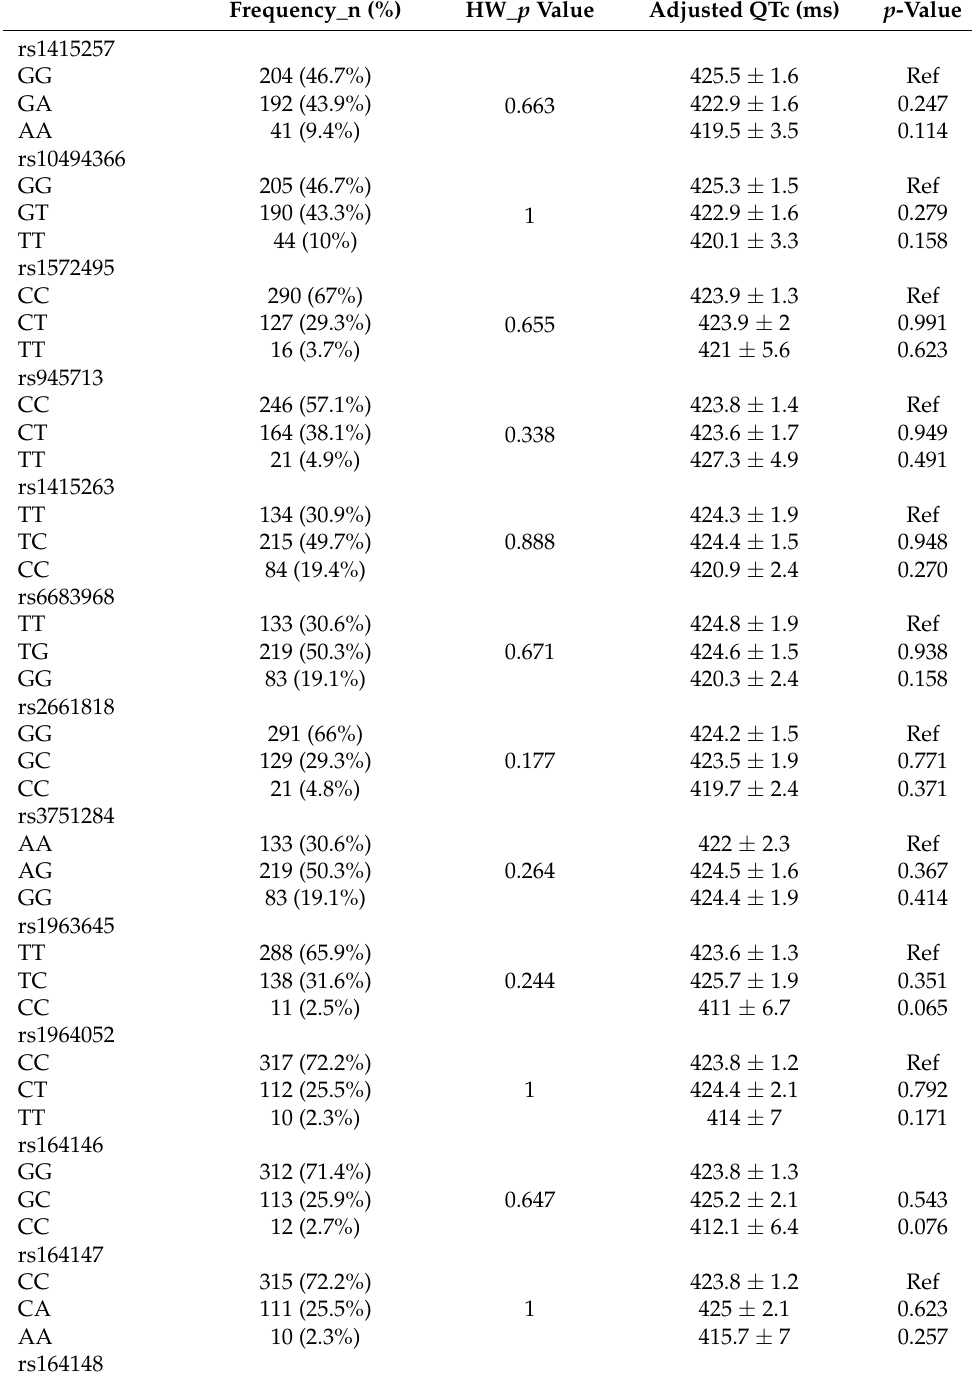
Table 2. Association between NOS1AP variants and QTc intervals during maintenance methadone treatment after adjusting for age, gender, and methadone